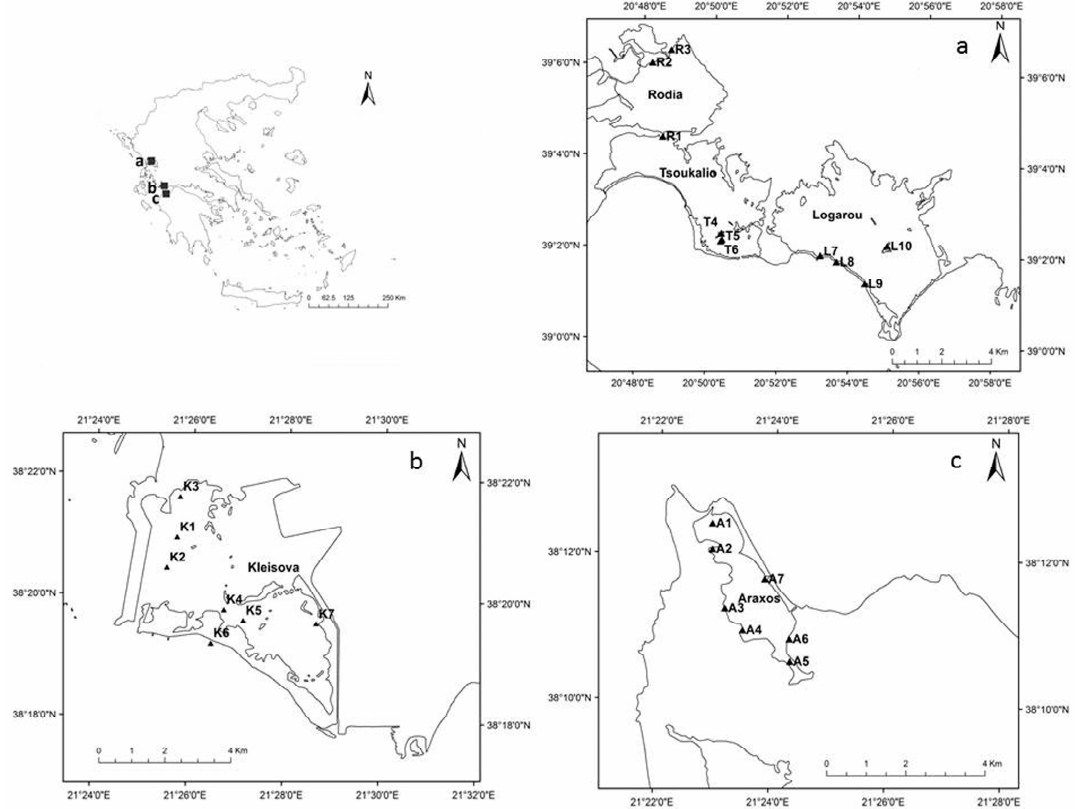
Figure 1. Maps and sampling stations of the investigated Western Greece coastal lagoons: ( a ) Rodia (Type I); Tsoukalio and Logarou (Type II) ‐ Amvrakikos Gulf; ( b ) Kleisova (Type II) ‐ Messolonghi ‐ Aitoliko lagoonal complex; ( c ) Araxos (Type III).